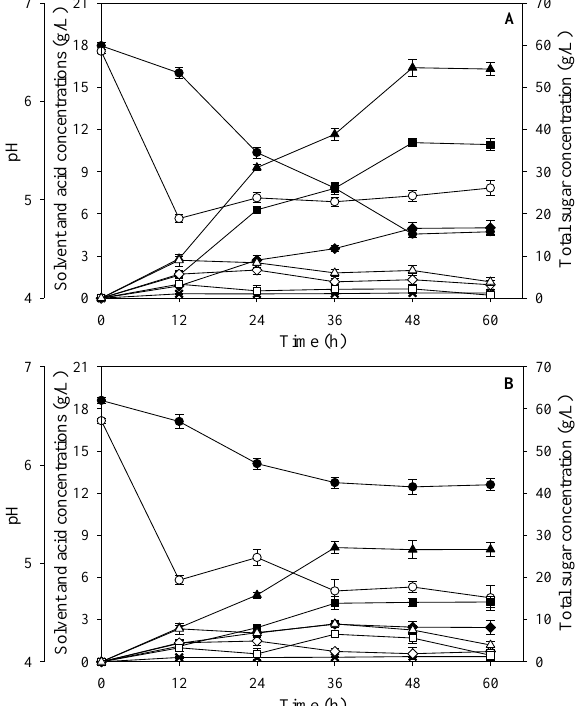
Figure 2. Batch butanol fermentation profiles from the P2 medium ( A ) and SSJ medium with no nutrient supplementation ( B ) using free cells of C. beijerinckii TISTR 1461: acetone ( ♦ ), butanol ( ■ ), ethanol (×), ABE ( ▲ ), acetic acid (◊), butyric acid (□), total acid (Δ), pH ( ○ ), and total sugars (●). Table 4. Batch butanol fermentation efficiency profiles for the P2 medium and SSJ medium containing various nitrogen sources.